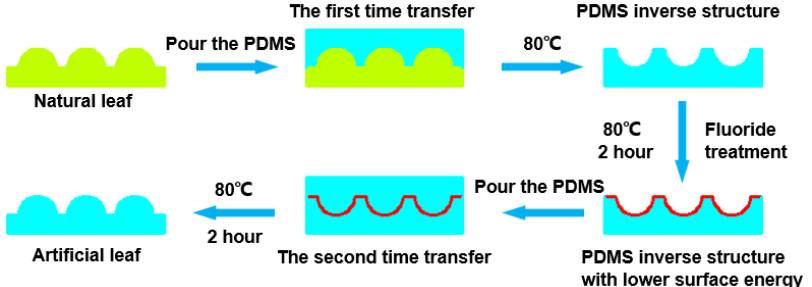
Figure 1. The schematic illustrating the template transfer technique for the fabrication of biomimetic Phragmites communis leaves (PCLs).